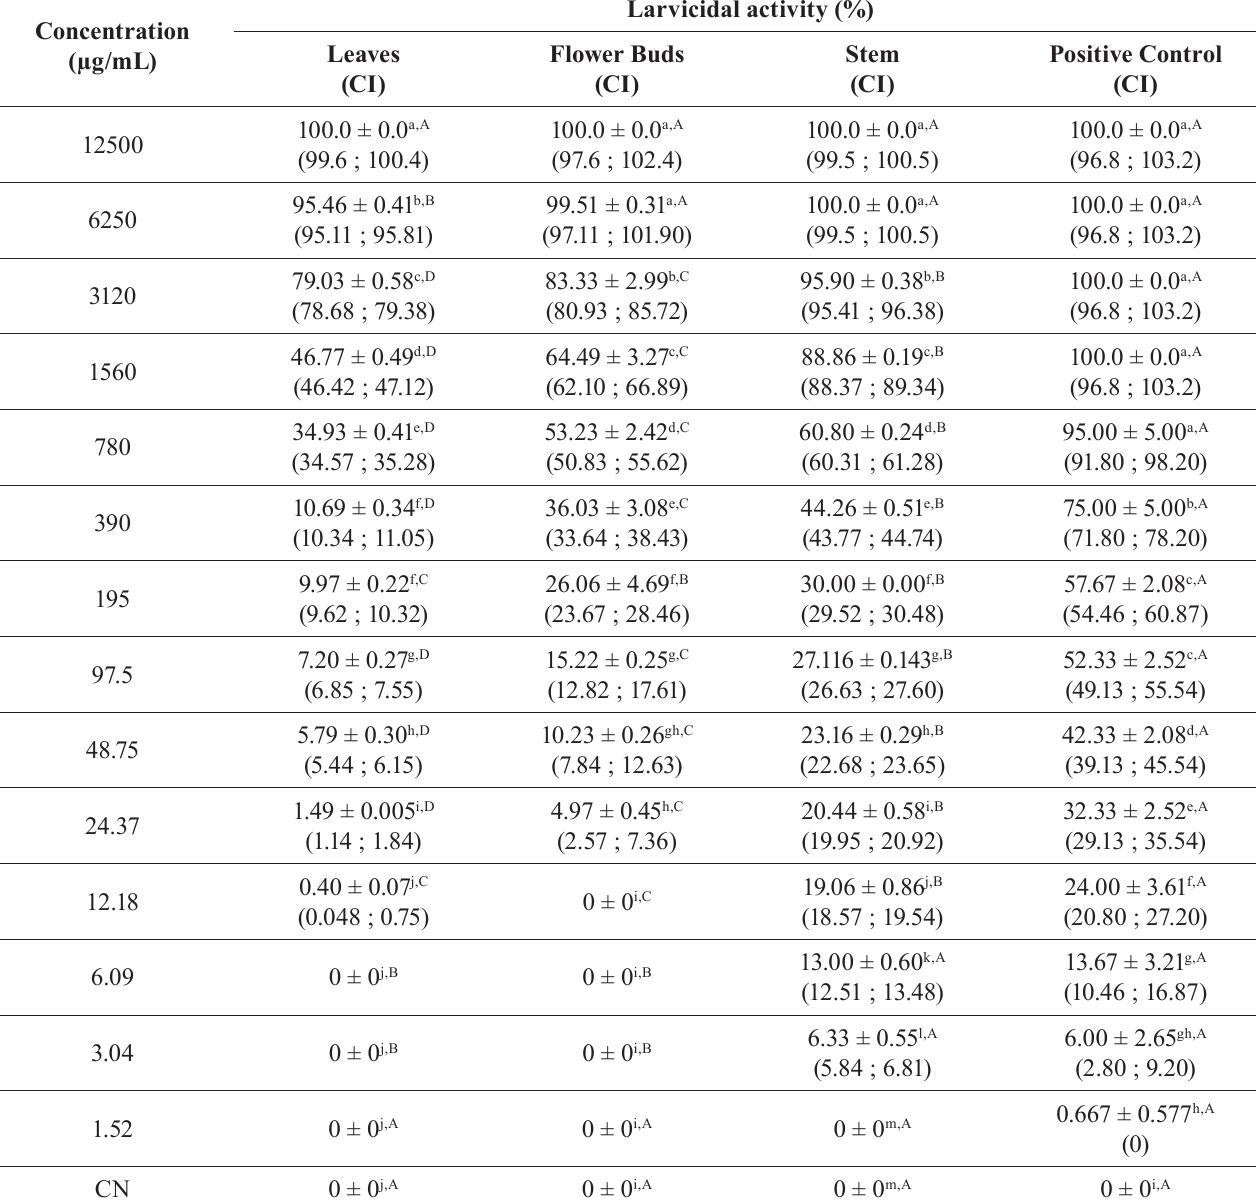
TABLE II - Larvicidal activity by Larval Immersion Test (LIT) (%) and Lethal concentration LC confidence interval (CI α = 0.05) of Tetradenia riparia leaves, flower buds and stem essential oils that killed the larvae